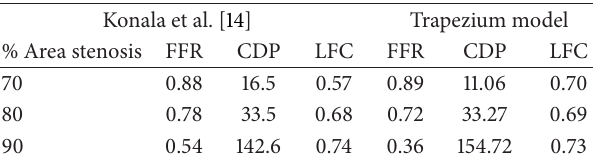
Table 2: Comparison of diagnostic parameters for trapezium model with rigid artery with rigid plaque wall model reported by Konala et al.